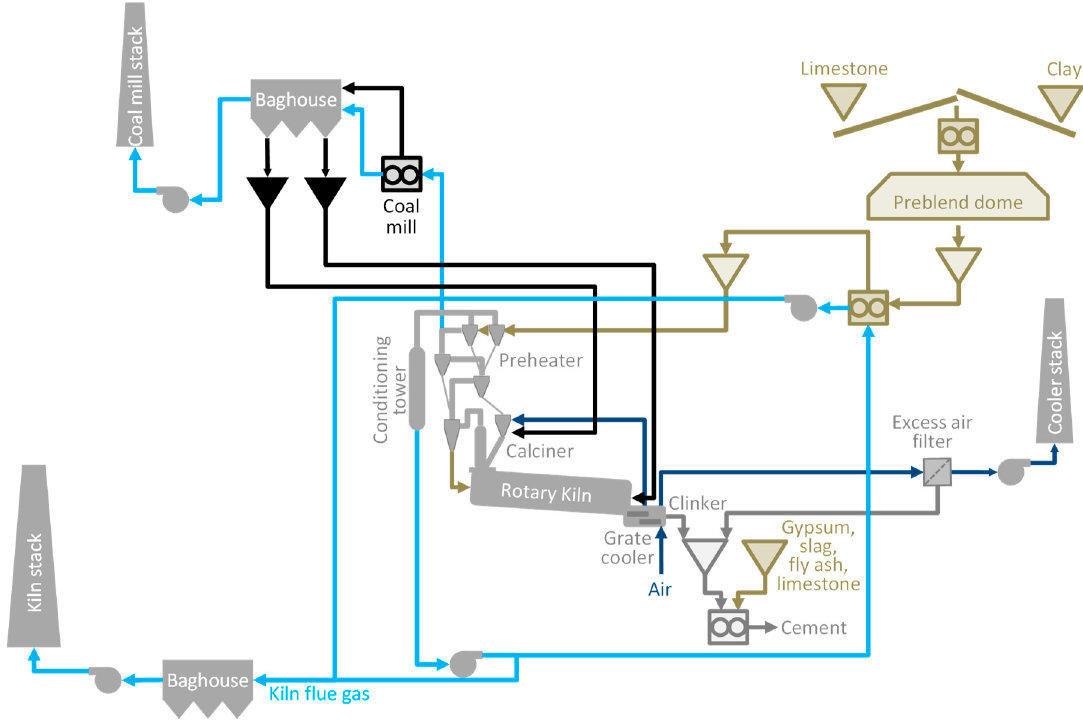
Figure 1. Scheme of a state-of-the art cement manufacturing process.